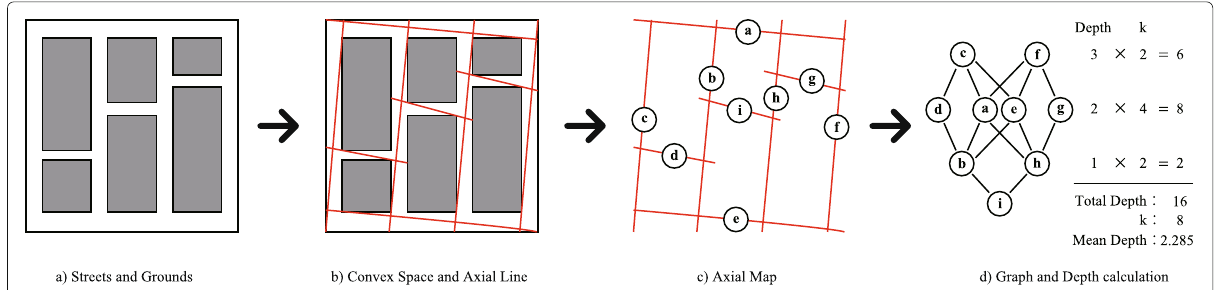
Fig. 1 Relationship between Convex Space and A-Line. a) Streets and Grounds. b) Convex Space and Axial Line. c) Axial Map. d) Graph and Depth